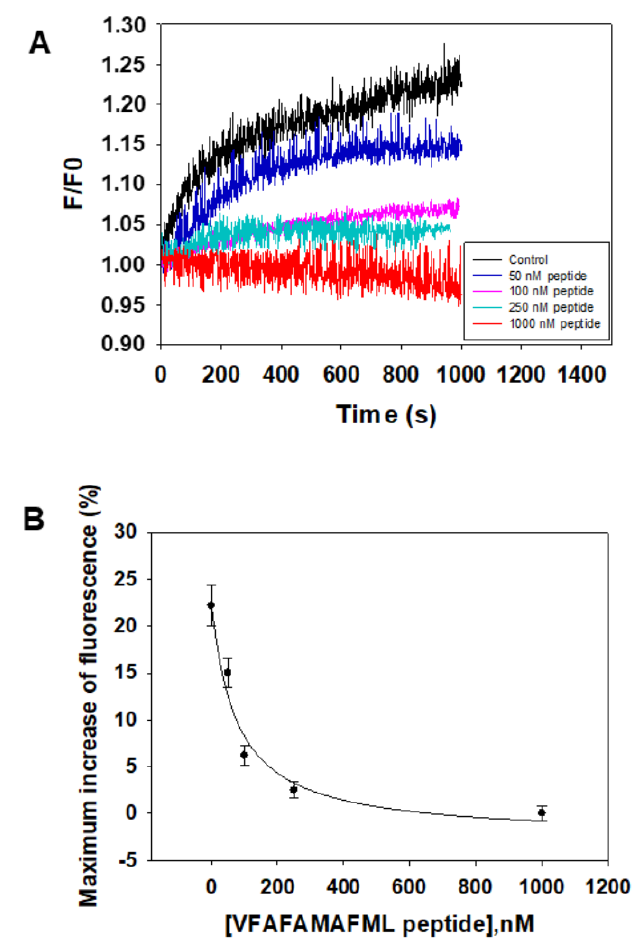
Figure 4. The synthetic peptide VFAFAMAFML (amidated-C-terminus amino acid) antagonizes A β (1–42):CaM complex formation. ( A ) Effect of increasing concentrations of this synthetic peptide on the kinetics of increase of the fluorescence intensity of 10 nM A β (1–42) HiLyte TM -Fluor555 after the addition of 5 nM CaM. Titration with the synthetic peptide and fluorescence measurements have been performed as indicated in the Materials and Methods. The kinetics of fluorescence were recorded in the presence of the following concentrations of the peptide VFAFAMAFML (amidated-C-terminus amino acid): 0 (black), 50 nM (dark blue), 100 nM (pink), 250 nM (cyan) and 1000 nM (red). ( B ) Plot of the dependence of the maximum increase of fluorescence recorded 1000 s after the addition of CaM as a function of the concentrations of the peptide VFAFAMAFML (amidated-C-terminus amino acid). The data shown are the average (black-filled circles) ± S.E. (error bars) of the results obtained in triplicate measurements. The continuous line is the non-linear square fit of the data to the hyperbolic equation for a one site binding drug-inhibitory effect: Y = Y0 − [Qmax × x/(IC50 + x)], where Y0 is the maximum fluorescence increase in the absence of the peptide, Qmax is the maximum quenching of the increase of fluorescence at saturation of the peptide and IC50 is the concentration of the peptide that reduces to half the maximum increase of fluorescence. The data fitting gave the following results: R 2 = 0.966, Y0 = 22%, Qmax = 22% and IC50 = 75 ± 10